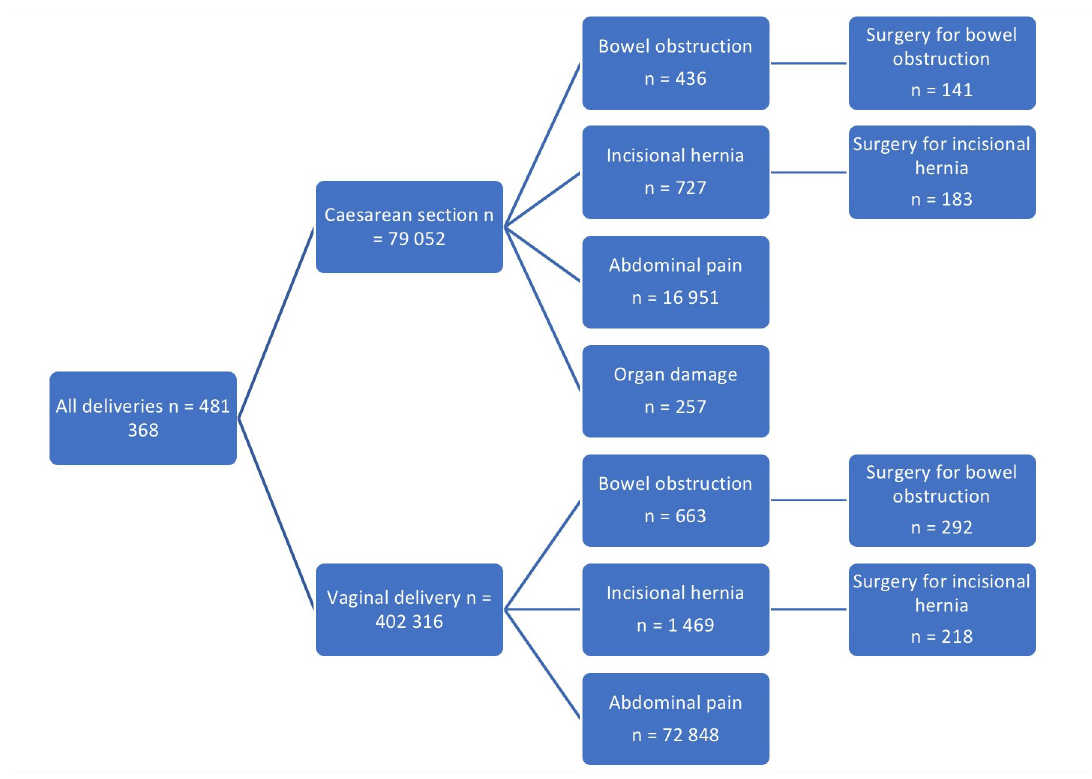
Fig 1. Flow chart of patients included and surgical complications after caesarean section and vaginal delivery controls. Primiparas.